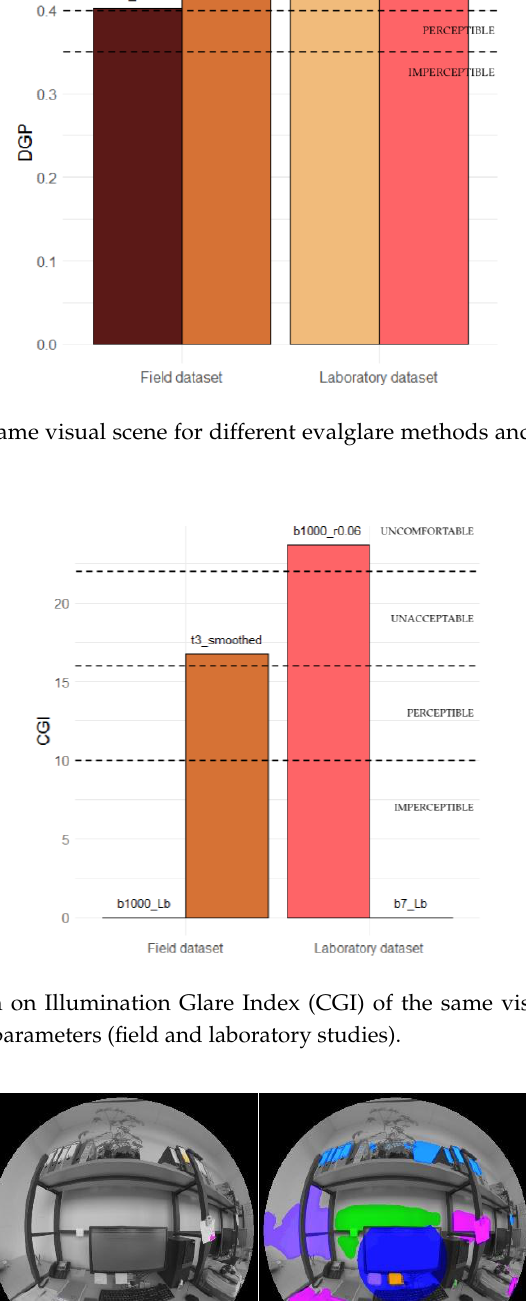
Figure 43. Extreme example (laboratory study) of the difference in glare source(s) detection resulting from the b1000_r0.06 setting ( left ) and the b7_Lb setting ( right ) in evalglare. To conclude, for predominating saturation glare scenes, it would be beneficial to use an absolute threshold of 2000 cd/m 2 . This method should also be preferred for simulation work with an observer location close to the façade. Using the task area method with a factor 4 or 5 delivers for all of the investigated cases (saturation and contrast glare scenes) reasonable results and it is the preferred option for predominating contrast glare scenes. This method should be applied in simulation work, when the observer is located further away from the façade, although the task area definition might be sensitive. Using the factor method—evalglare default method—was found to lead to significantly lower performances and is therefore not recommended. From this study, the influences of the background luminance definition, the search radius, and the task area size were found to be not statistically significant. It is therefore recommended to use the default setting for these parameters. Further research on the definition of a glare source in daylighting is required, so that these parameters can be determined knowingly and reliably.